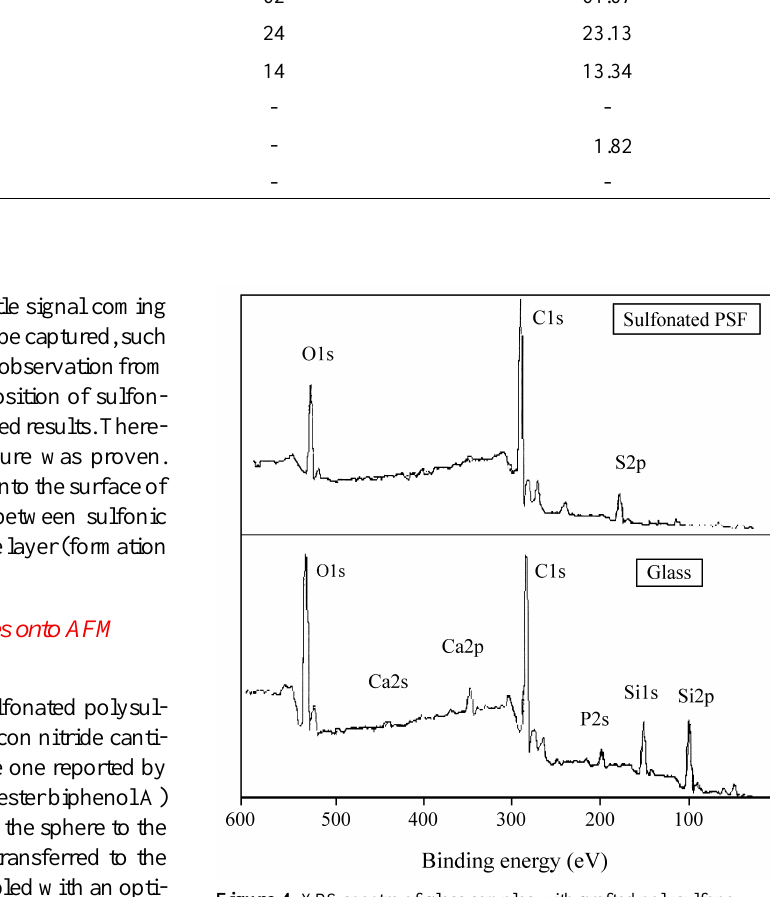
Figure 4. XPS spectra of glass samples with grafted polysulfone.